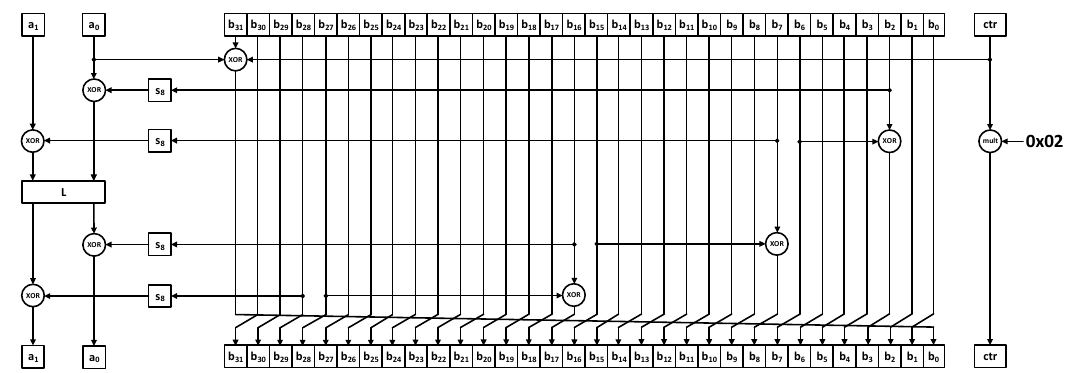
Figure 1. The architecture of Enocoro-128v2 stream cipher according to [9].